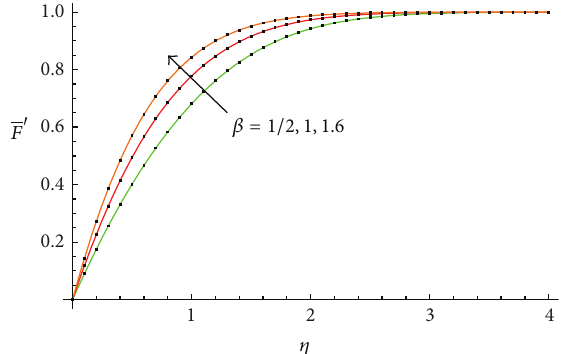
Figure 6: Comparison between the velocity profile obtained from (53), (61), and (69) and numerical results for 𝛽 = 1/2 , 1, and 1.6, respectively: —numerical; ... OHAM solution.